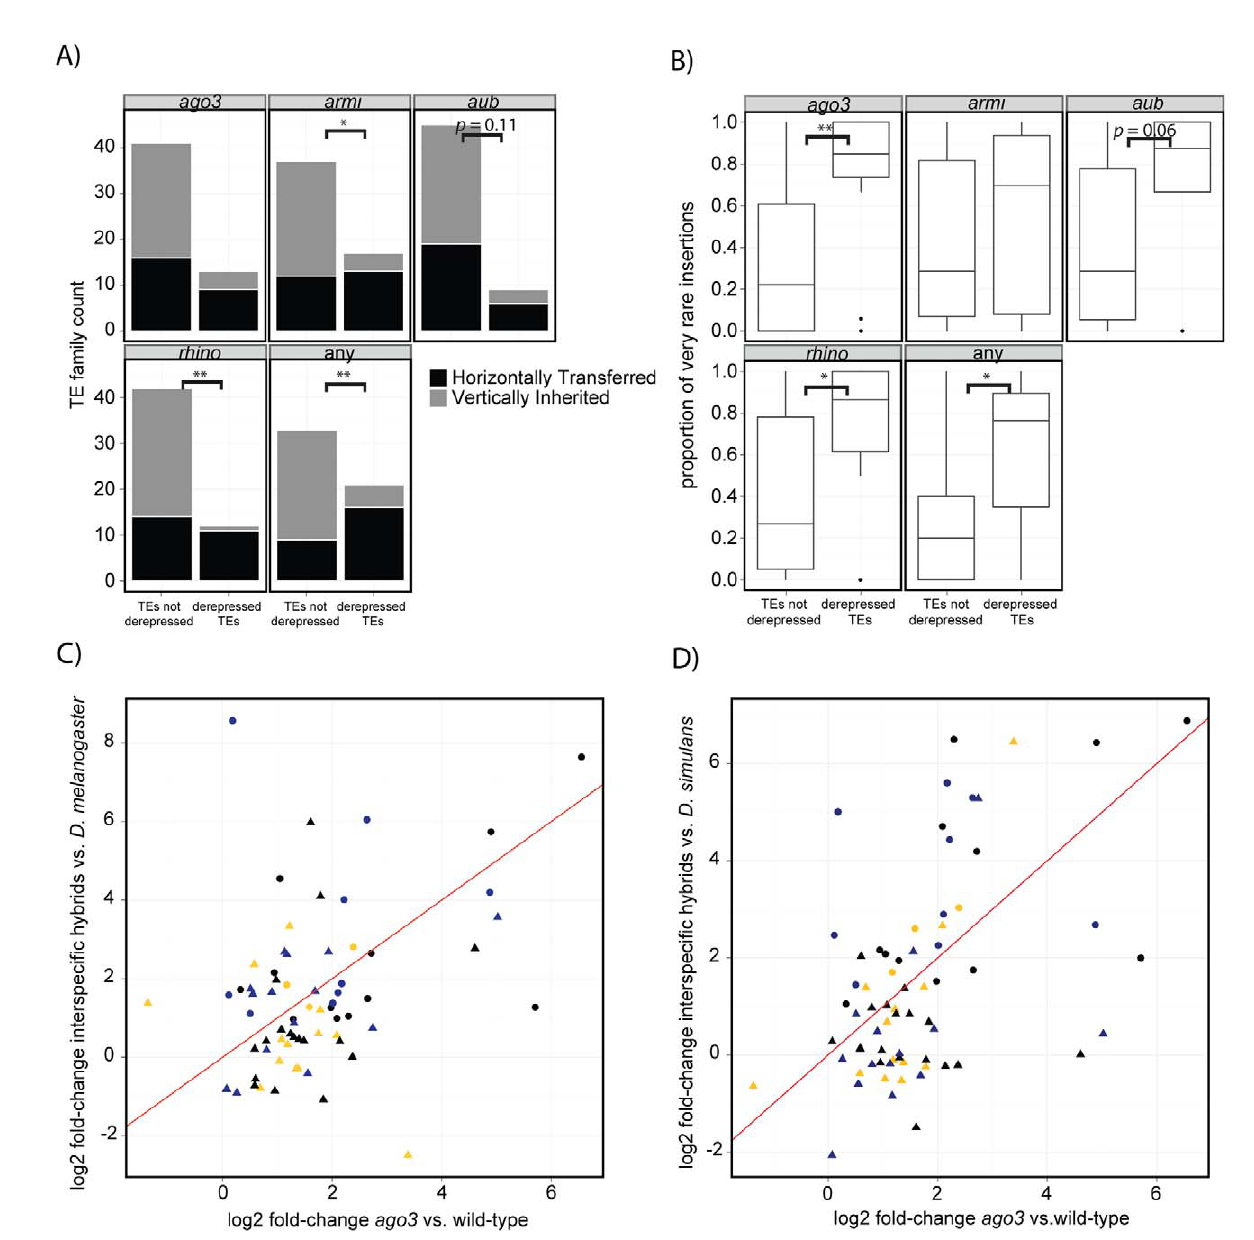
Figure 3. TE activity in interspecific hybrids phenocopies piRNA pathway mutants. (A) TE families derepressed in four piRNA pathway mutants are enriched for candidates for recent horizontal transfer [10,12]. Significance of comparisons between derepressed TE families and nonderepressed TE families was determined by a G- test of independence. ‘‘Any’’ category considers all TE families derepressed in one or more of the four mutant backgrounds. Derepressed TE families are from [44,45]. (B) TE families derepressed in four piRNA pathway mutants exhibit a higher proportion of insertions segregating at very low frequency [52,53]. Statistical significance was assessed by a Wilcoxon Rank Sum Test. (C and D) Changes in TE activity in interspecific hybrids versus D. melanogaster (C) and D. simulans (D) correlate with changes in TE activity in ago3 mutants versus wild-type D. melanogaster [45]. Color of TE classes is from Figure 1C and suggests that these correlations are independent of interspecific differences in the piRNA pool. Circles and triangles represent TE families derepressed and nonderepressed, respectively, in interspecific hybrids (Figure 1A). Red line indicates the best fit regression line. * p , 0.05. ** p , 0.01. *** p , 0.001.